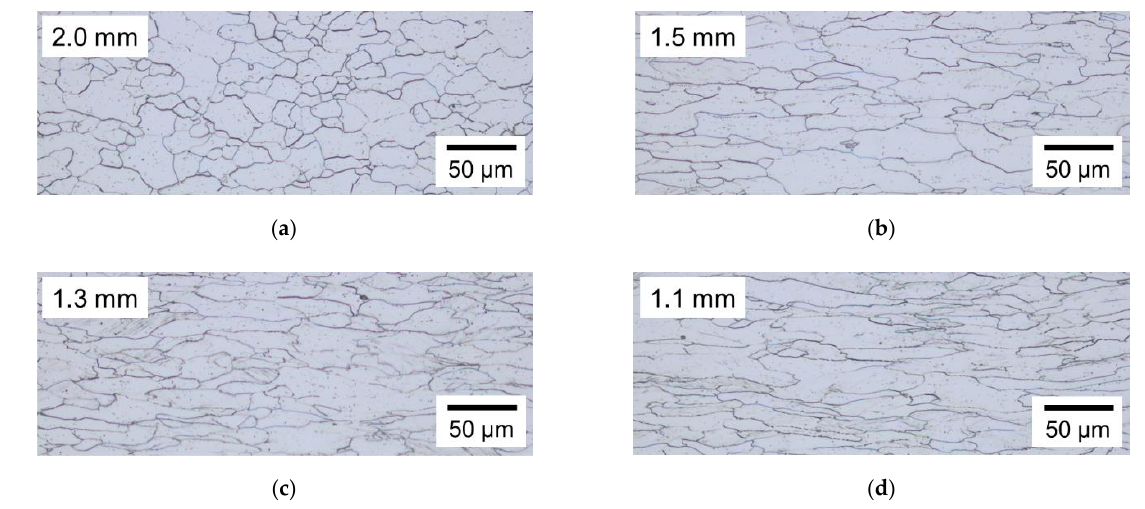
Figure 3. Optical microscope images of longitudinal sections of DC04 sheets with sheet thicknesses of ( a ) 2.0 mm, ( b ) 1.5 mm, ( c ) 1.3 mm, as well as ( d ) 1.1 mm.